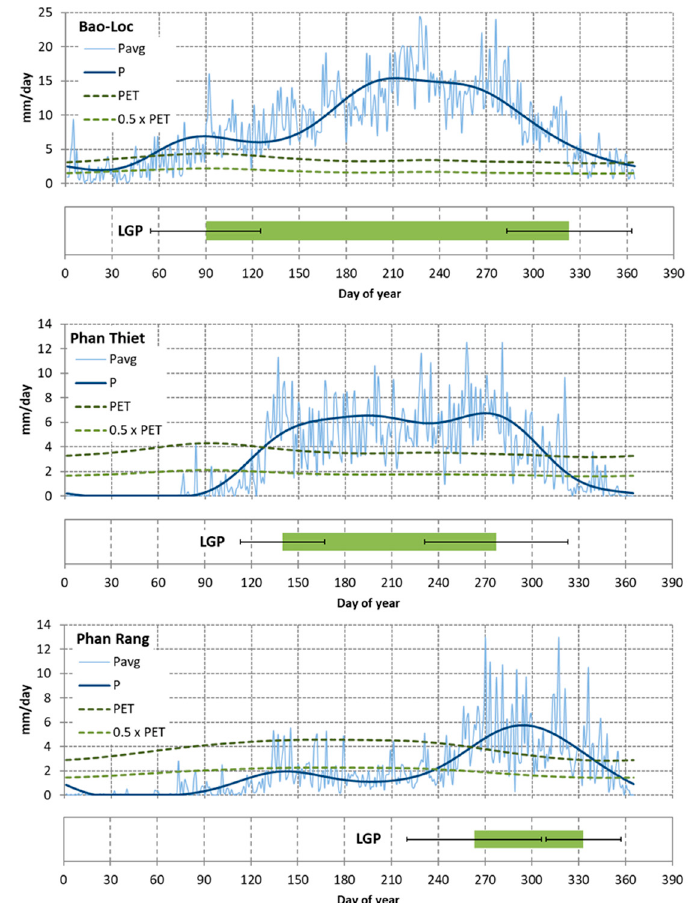
Figure 5. Bio-meteorological variability at Bao-Loc, Phan Thiet and Phan Rang for 1980–2009 (location see Figure 2). Pavg is average daily rainfall. Rainfall (P) and potential evapotranspiration (PET) are 30-year moving average values for rainfall and evapotranspiration, respectively. The length of the growing period (LGP) is the length of the growing period in days, error bars represent the range between the 10th and 90th percentile in start and end date. Note: the scaling of the y -axis is not equivalent for the three